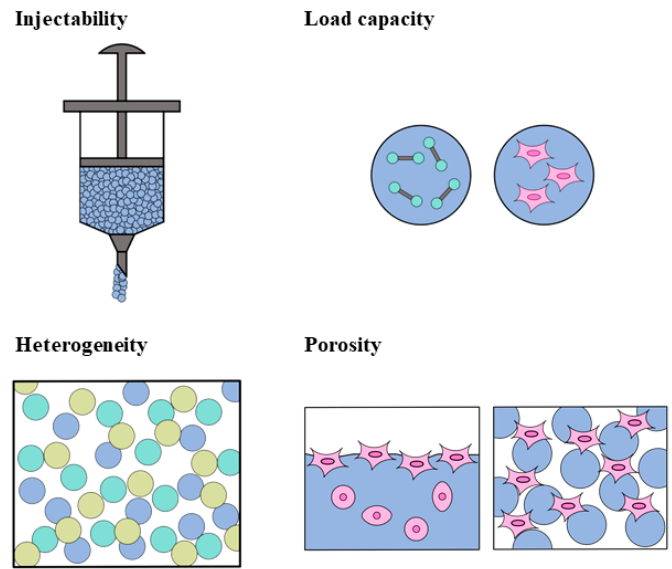
Figure 6. Advantages of hydrogel microspheres for nerve repair.